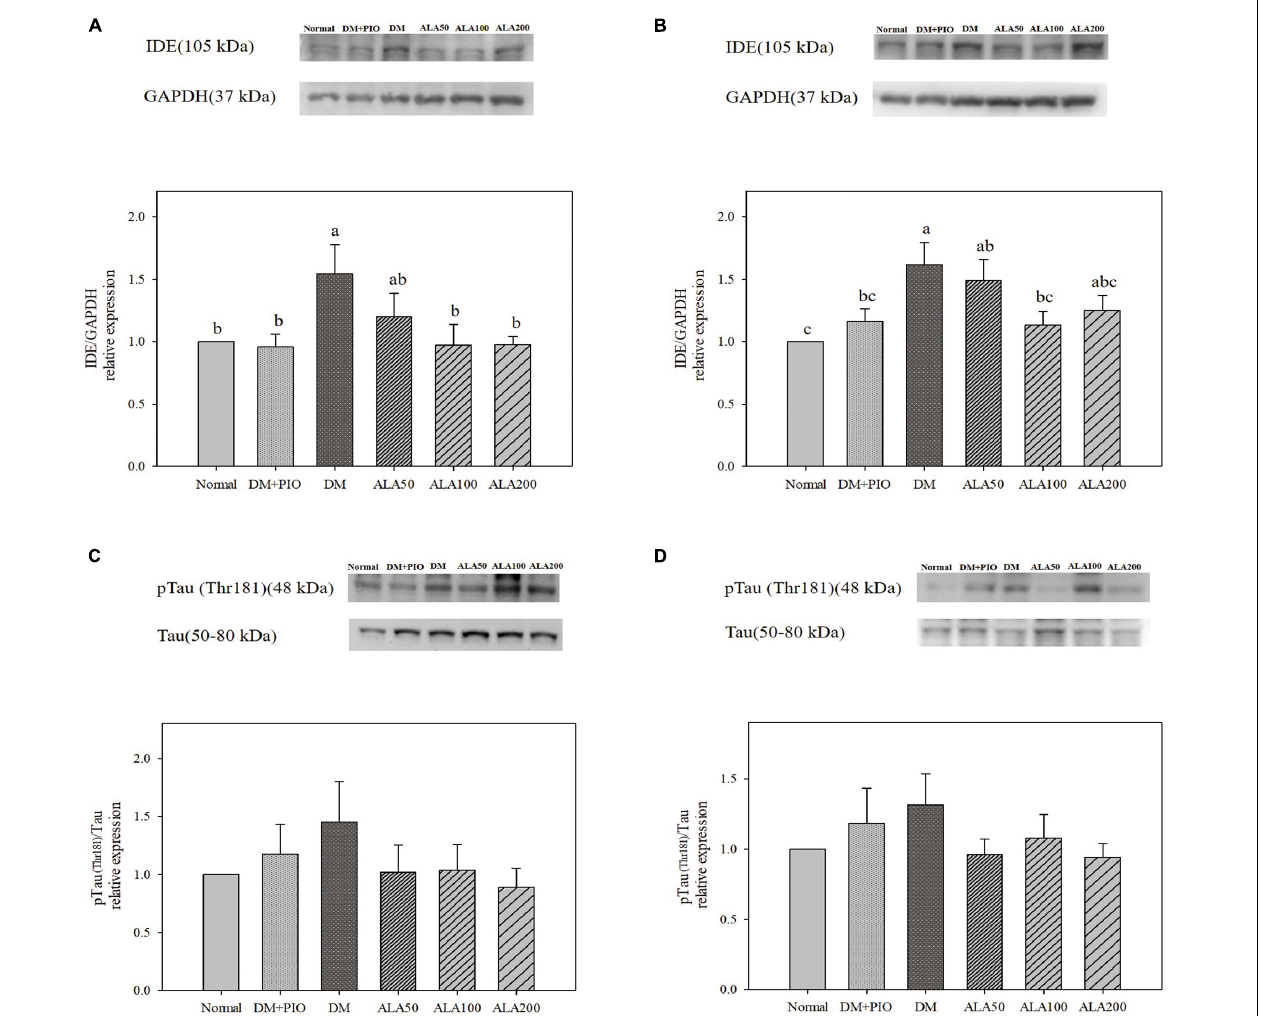
FIGURE 3 | Protein levels of IDE in the hippocampus (A) and cortex (B) , and pTau (Thr181)/Tau levels in the hippocampus (C) and cortex (D) in high-fat diet and streptozotocin-induced type 2 diabetic rats treated with alpha-lipoic acid for 13 weeks. Normal, Normal diet; DM, high-fat diet (HFD; 60% fat) with STZ (30 mg/kg body weight, i.p.) induced diabetic rats; DM + Pio, DM rats gavaged with pioglitazone (30 mg/kg body weight) for 13 weeks; DM + ALA50, DM rats gavaged with ALA (50 mg/kg body weight) for 13 weeks; DM + ALA100, DM rats gavaged with ALA (100 mg/kg body weight) for 13 weeks; DM + ALA200, DM rats gavaged with ALA (200 mg/kg body weight) for 13 weeks. Values were calculated as the mean ± SEM, n = 6 for each group. a–c letter is significantly different among all samples tested ( p <